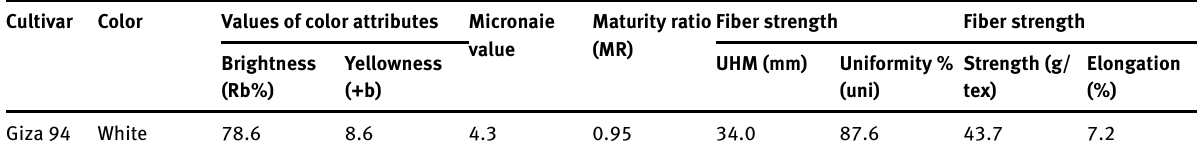
Table 1: Fiber quality characteristics of the Egyptian long staple cotton cultivar ‘Giza 94’ Cultivar Color